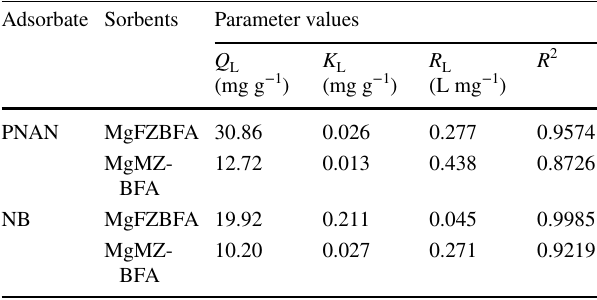
Fig. 15 Freundlich isotherm plots for the sorption of a PNAN b NB on MgFZBFA and MgMZBFA Table 4 Langmuir isotherm parameters for the sorption of PNAN and NB on MgFZBFA and MgMZBFA Adsorbate Sorbents